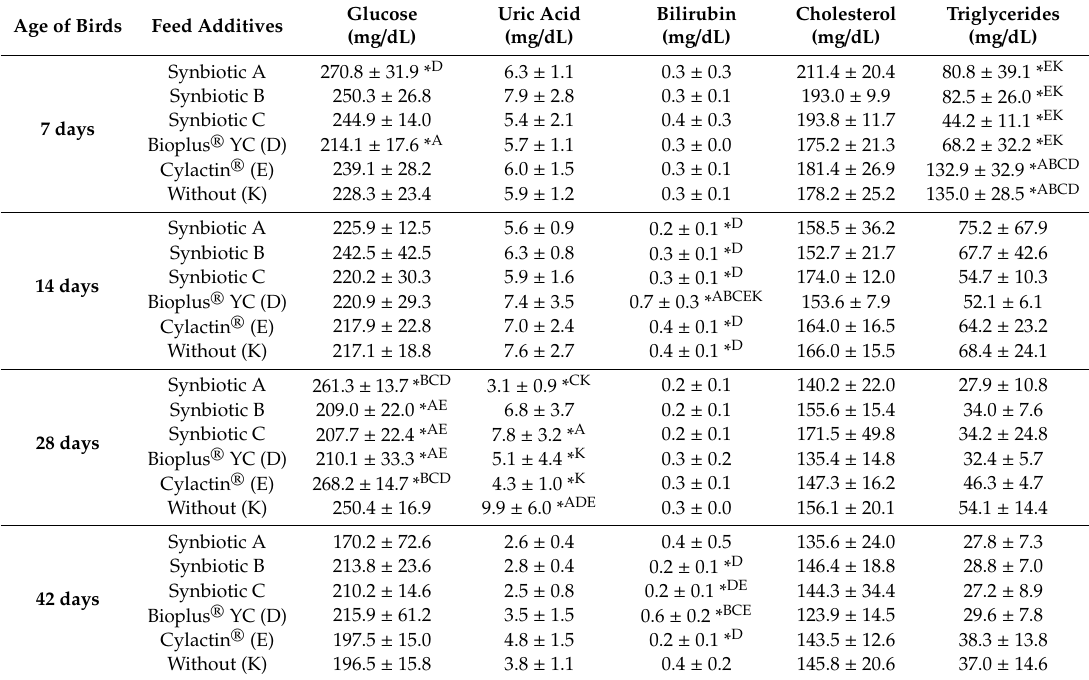
Table 5. Concentrations of the tested parameters in the blood serum of the experimental chickens. *—statistically significant di ff erences between groups, p ≤